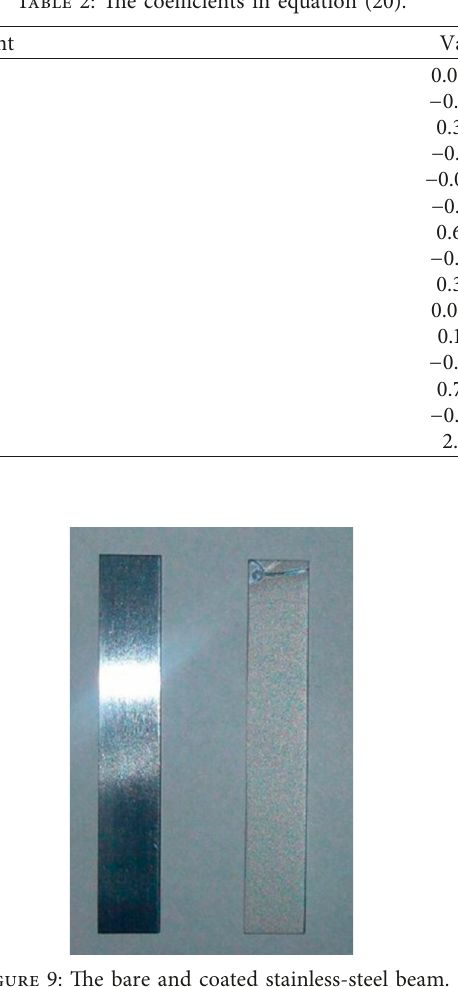
Figure 10: The experimental load versus depth curves of coated beam.